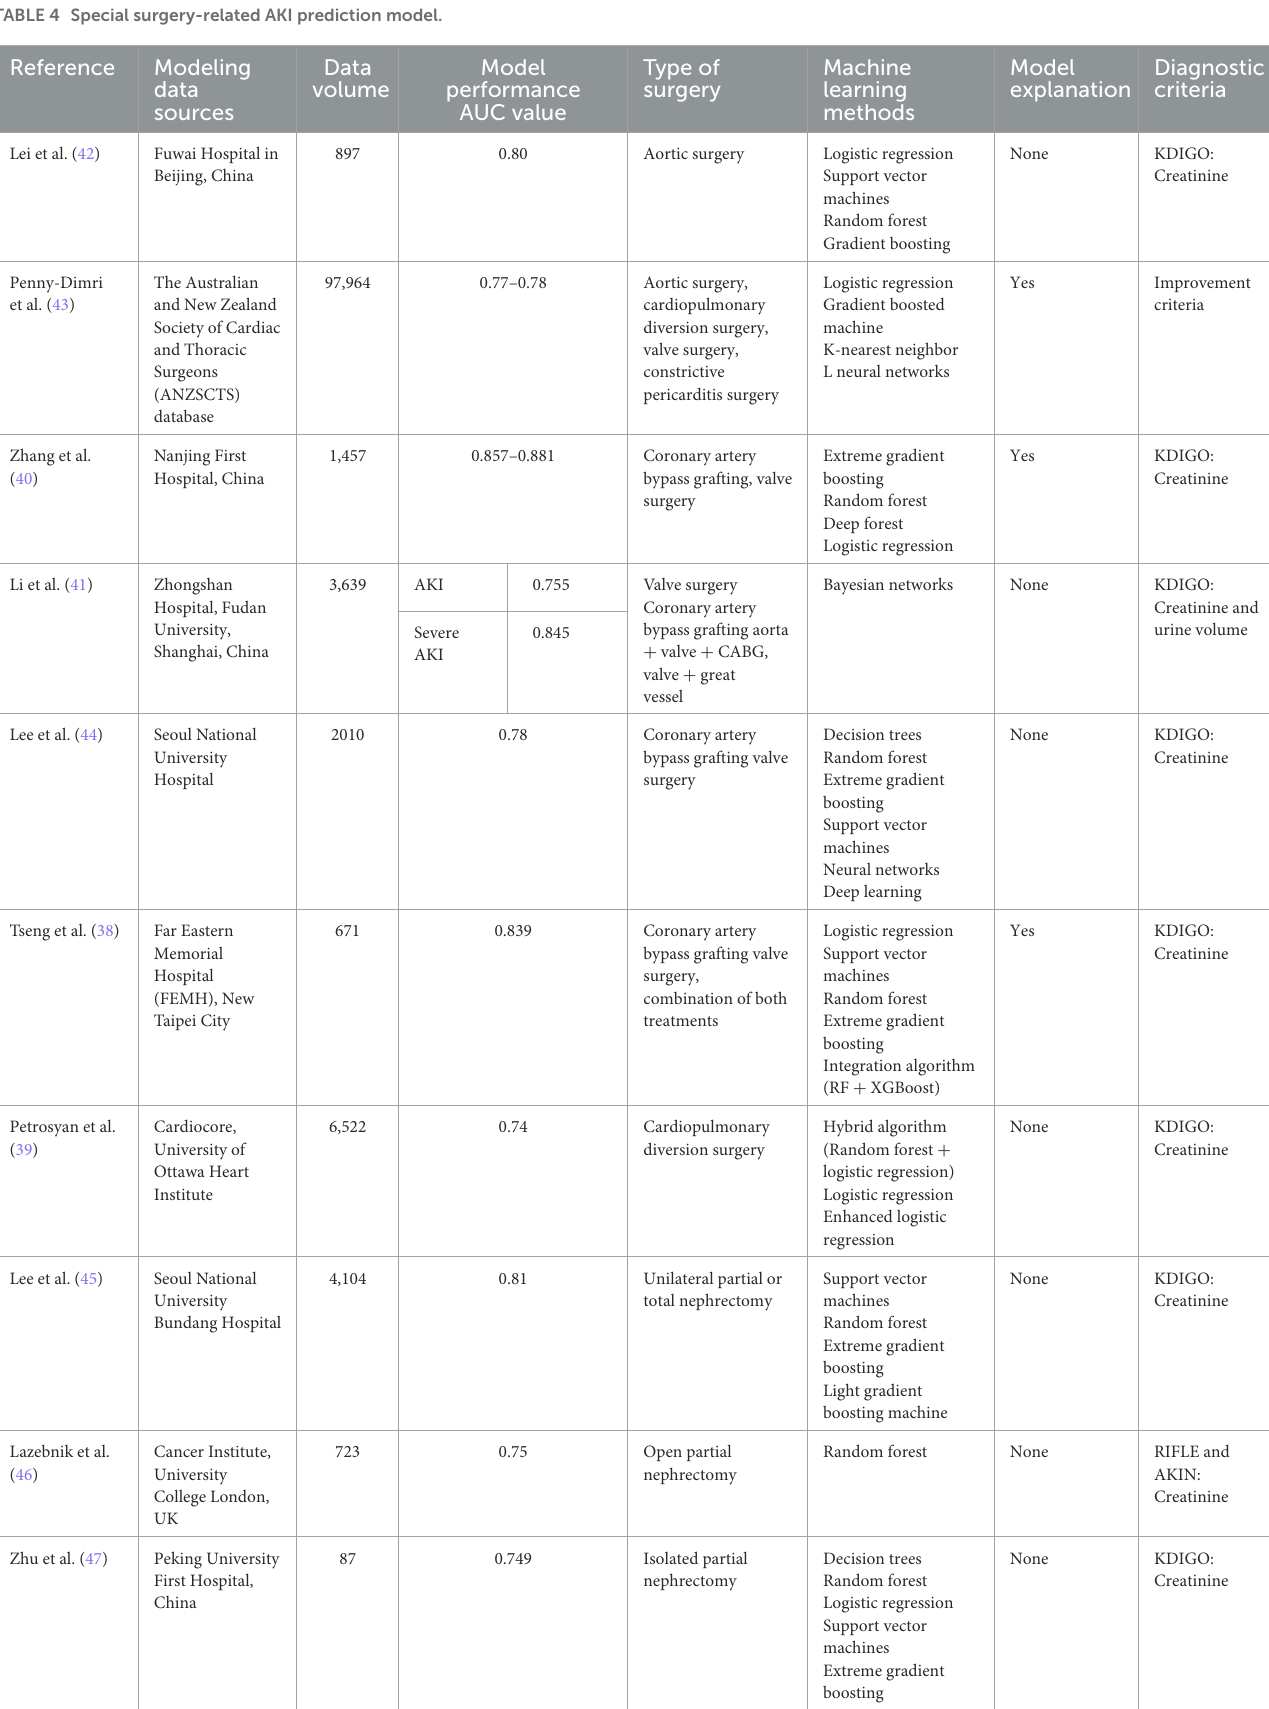
TABLE 4 Special surgery-related AKI prediction